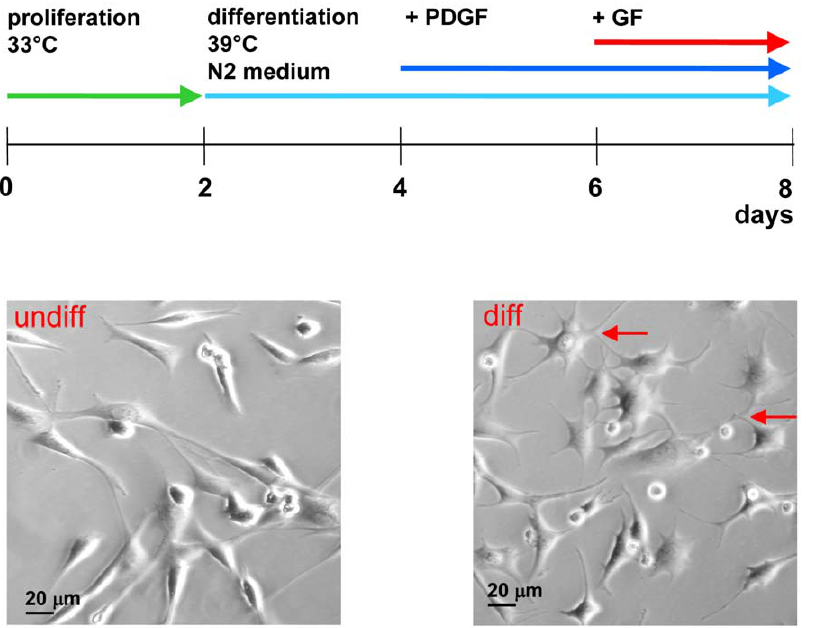
Figure 1. Treatment scheme for chronic influence of growth factors on expression of GABA cell marker. Cells were maintained for two days under proliferation conditions (undifferentiated (undiff) as shown in the left picture). For the first 4 days of differentiation, a routine differentiation protocol for HiB5 was followed (see methods section): after two days at 39 u C in N2 medium, PDGF (30 ng/ml) was added and the cells incubated for another 2 days. To study the influence of growth factors they were added at day 4 and cells incubated for another 2 days.